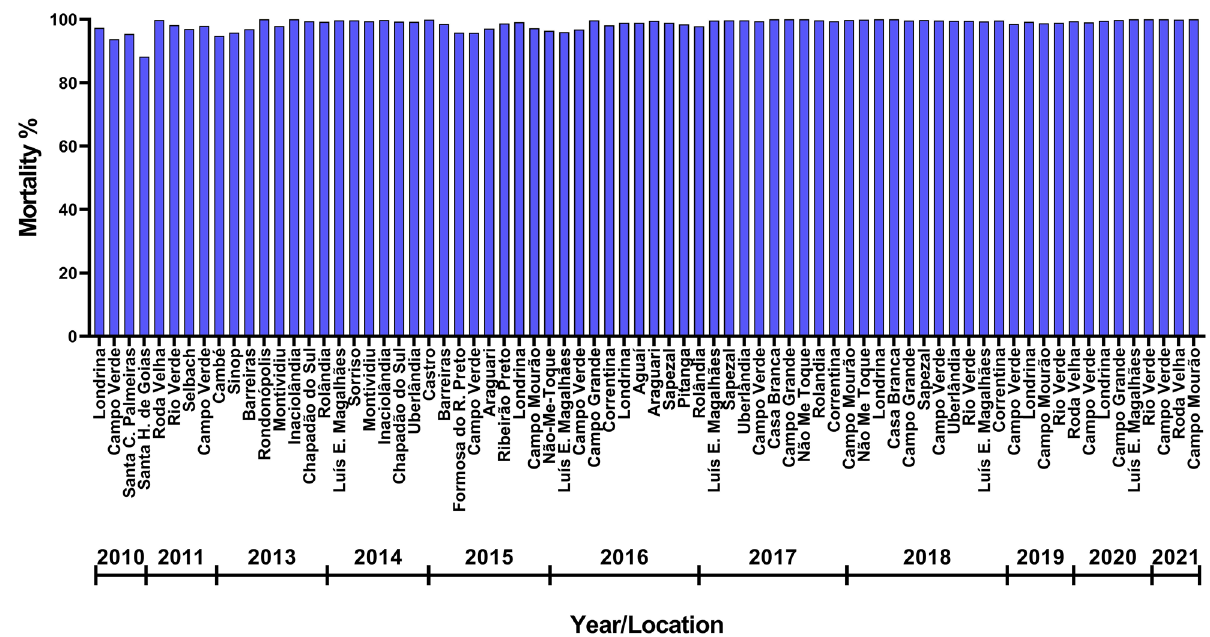
Figure 1. Susceptibility monitoring of C. includens populations from Brazil to Cry1Ac protein during 2009/10– 2020/21 using diagnostic concentration bioassay. Data from 2009/10 to 2014/15 were reported previously in Yano et al. 10